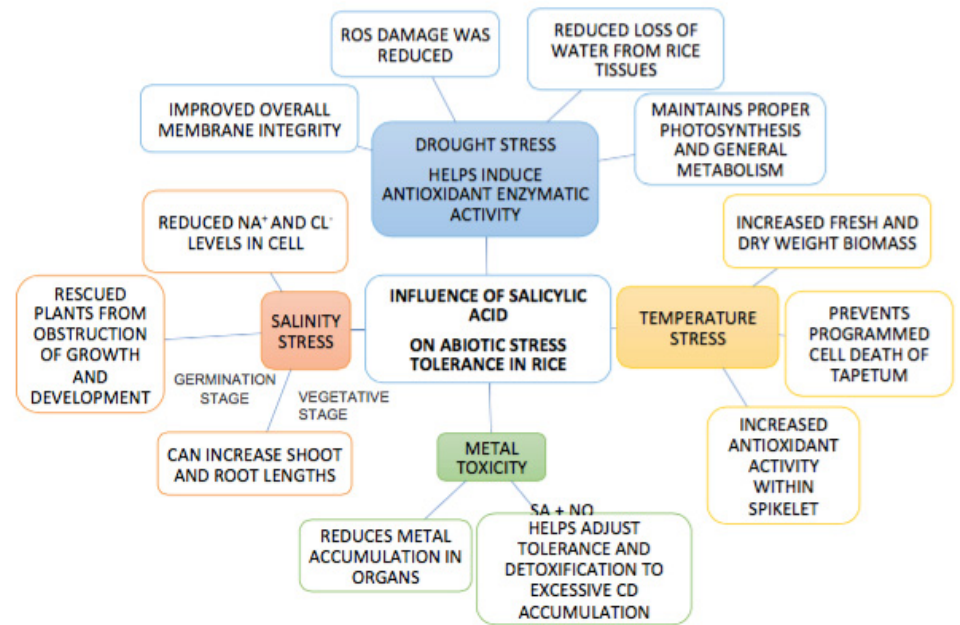
Figure 1. Schematic representation of the influences exerted by salicylic acid on rice when subjected to different abiotic stresses .